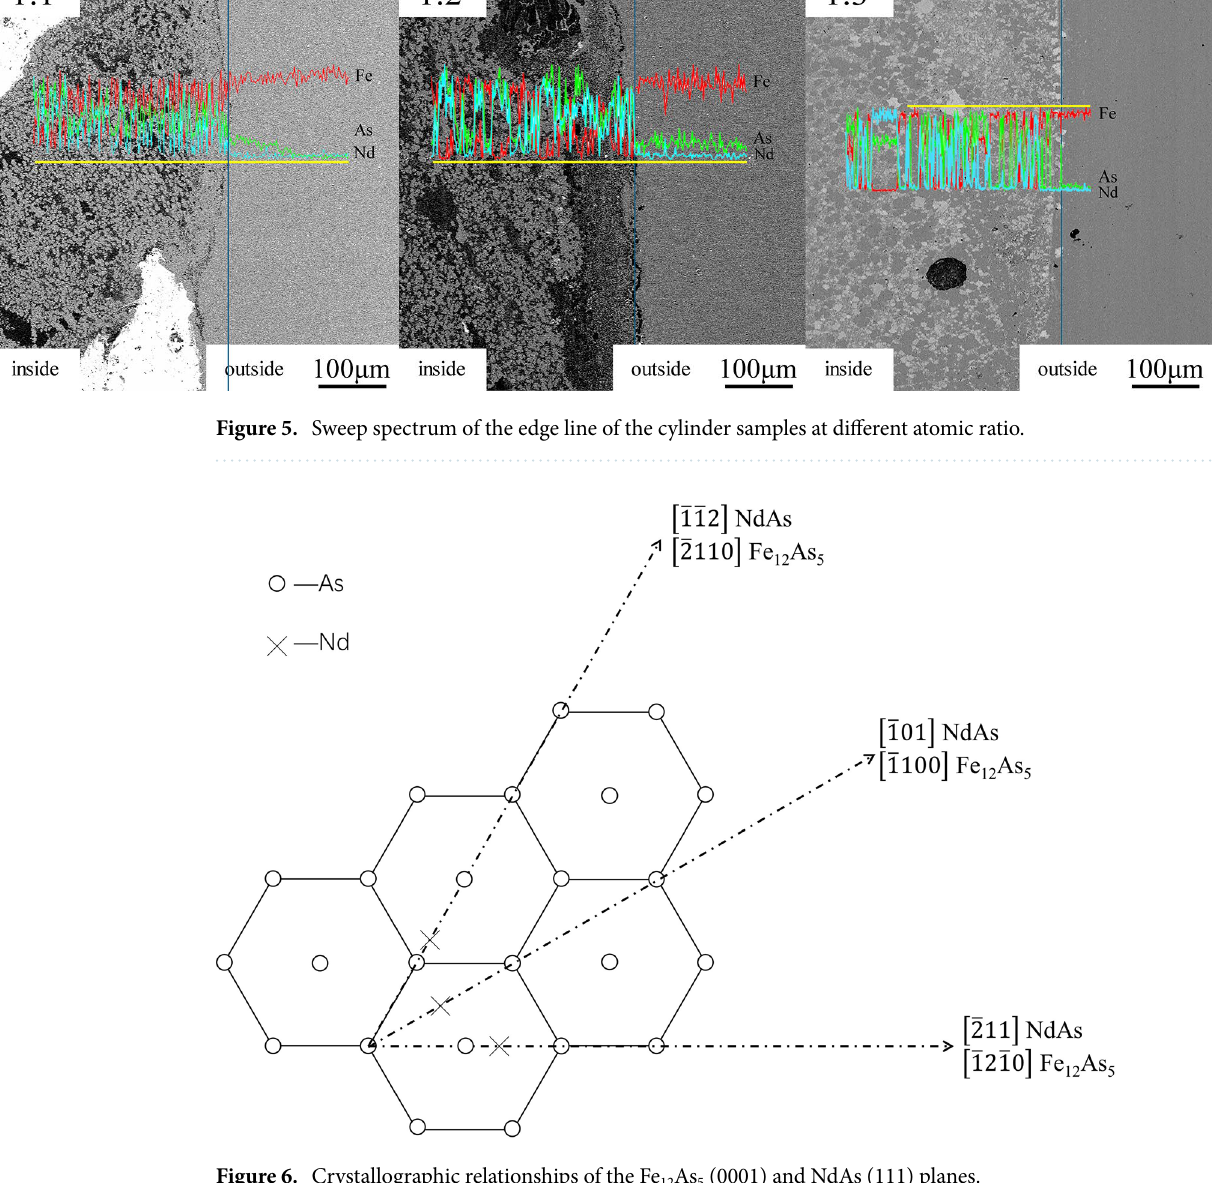
Figure 6. Crystallographic relationships of the Fe 12 As 5 (0001) and NdAs (111)